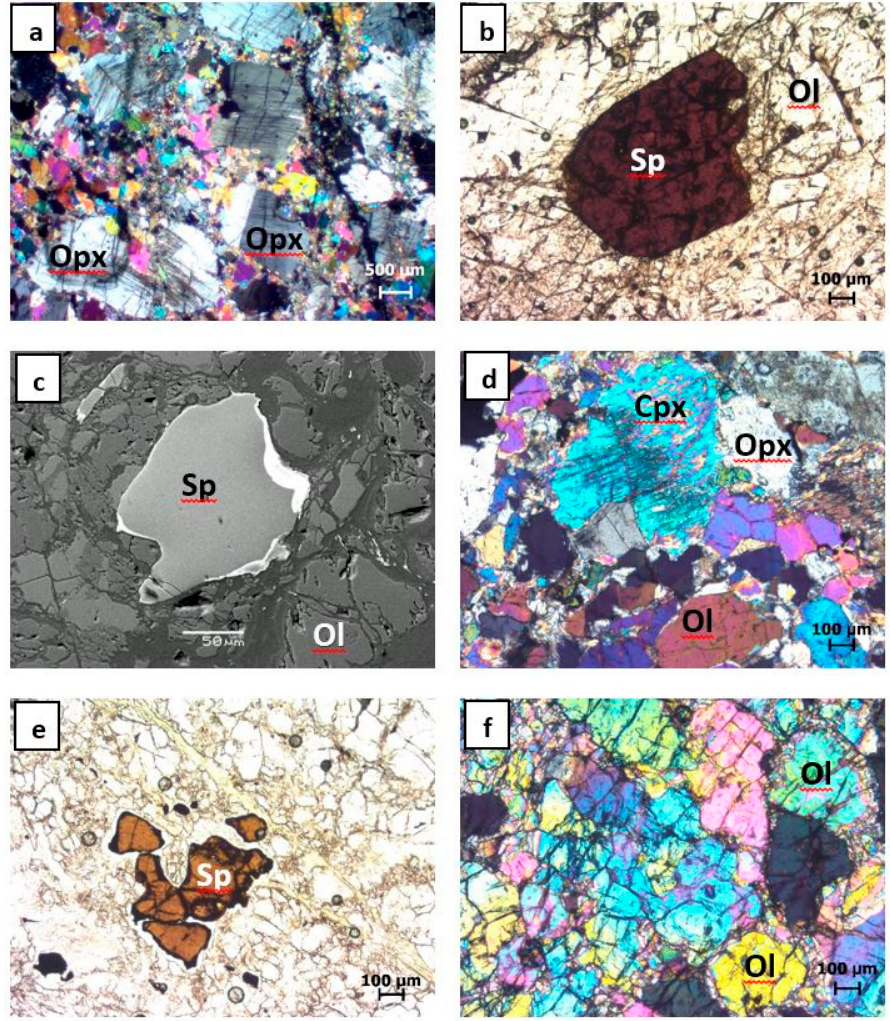
Figure 3. Photomicrographs of the studied mantle peridotites: ( a ) Porphyroclastic texture in harzburgite. Orthopyroxene porphyroclasts show undulose extinction, strain lamellae, kink bands, rotation, shearing and recrystallization (XPL, sample MG1, Megaplatanos); ( b ) Dark-brown coloured hypidiomorphic spinel grain in harzburgite (PPL, sample TR5, Tragana); ( c ) Back-scattered electron image of a spinel surrounded by magnetite (sample YP3, Ypato); ( d ) Porphyroclastic texture in lherzolite (XPL, sample ALY2, Alyki); ( e ) Light-brown coloured Al-spinel with lobate boundaries (PPL, sample ALY14, Alyki); ( f ) Granular texture in dunite (XPL, sample MG4, Megaplatanos). Abbreviations: Opx-Orthopyroxene, Cpx-Clinopyroxene, Ol-Olivine, Sp-Spinel, Mgt-Magnetite, XPL-Cross-polarized light, PPL-Plane-polarized light.